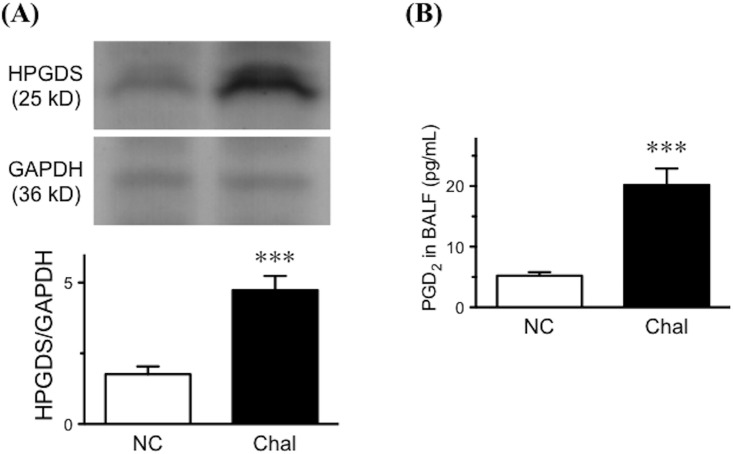
(A) Change in the expression levels of hematopoietic prostaglandin D synthase (HPGDS) protein determined by immunoblottings. (Upper panel) Representative blots for HPGDS and GAPDH. The bands analyzed by a densitometer and normalized by the intensity of corresponding GAPDH band, and the data are summarized in the lower panel. Results are presented as mean ± SEM from 5 animals in duplicate, respectively. ***P < 0.001 by unpaired Student’s t-test. (B) Change in prostaglandin D2
(PGD2) level in bronchoalveolar lavage (BAL) fluids of the antigen-challenged mice. Twenty-four hours after the last antigen challenge, BAL fluids were obtained, and PGD2 concentrations in BAL fluids were determined by enzyme-linked immunosorbent assay. Results are presented as mean ± SEM from 5 animals in triplicate, respectively. ***P < 0.001 by unpaired Student’s t-test.